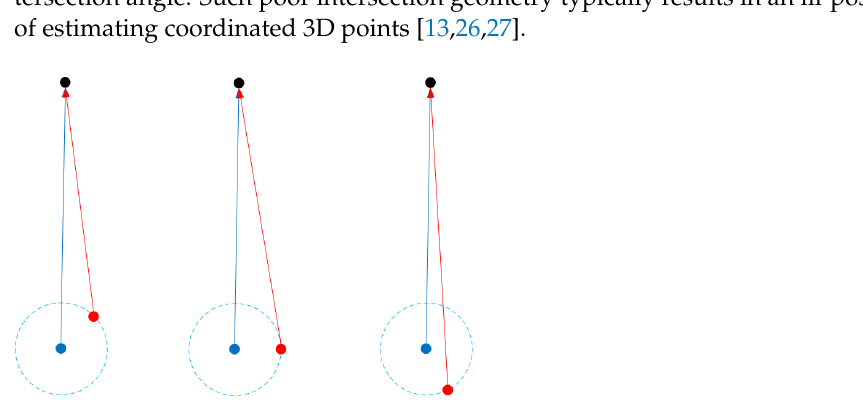
Figure 3. Different cases of two-view intersection with a constant baseline. Blue, red and black points indicate two images and one 3D point, respectively. Blue and red arrows indicate two view rays. The radius of circle (dotted line) indicates a constant baseline between two images